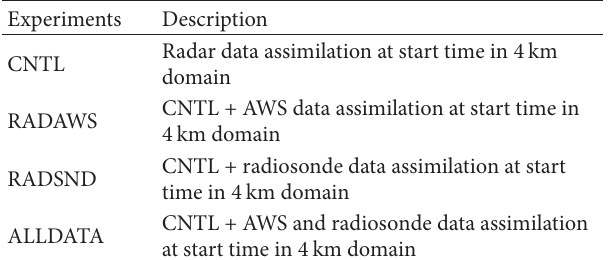
Table 1: Experiment